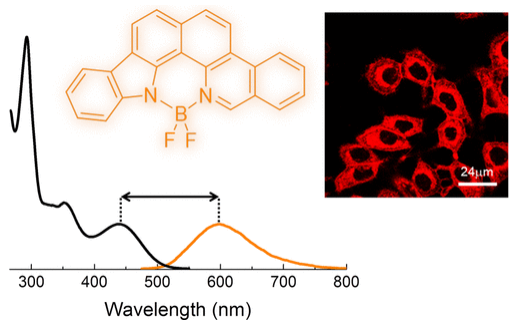
Figure 6. Left : Normalized absorption and fluorescence emission spectra of complex 6 . Right : Confocal fluorescence images of HeLa cells stained with compound 6 under a red channel. Adapted from [23].